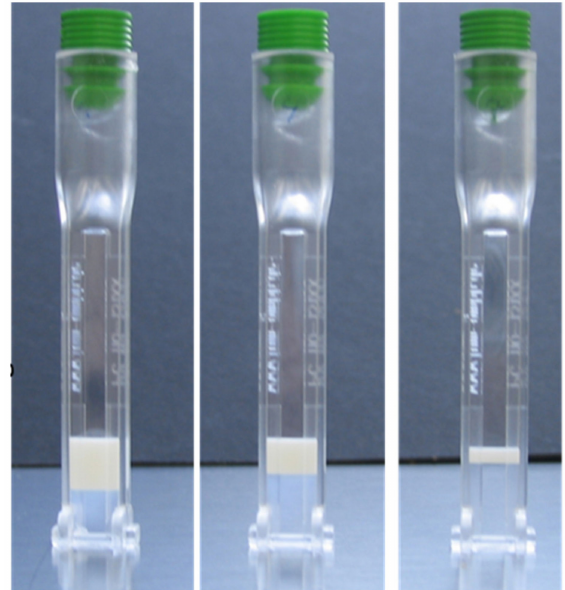
Figure 9. Double emulsions after centrifugation with an analytic centrifuge, LumiSizer (LUM GmbH, Berlin). Di ff erent amounts of transparent phase show di ff erent amounts of outer water phase. W1 / O / W2 phases consist of aqueous 0.35 wt % NaCl solution, canola oil with PGPR and of aqueous whey protein isolate,